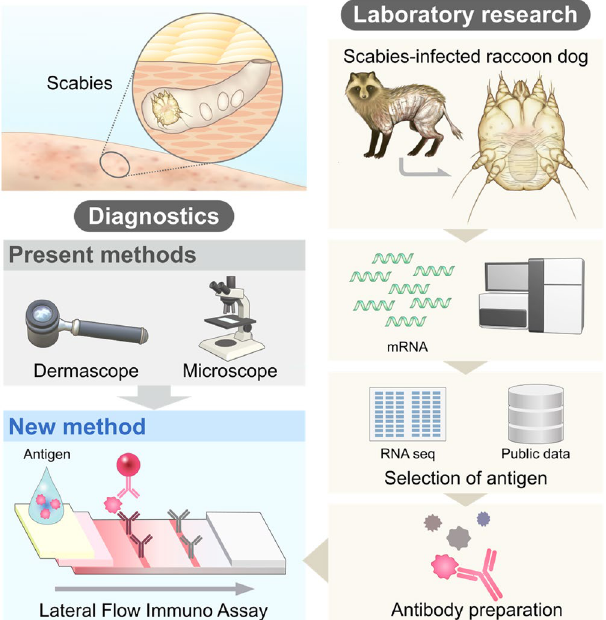
Figure 1. Schematic overview of this study for the development of a lateral immunoassay for scabies diagnosis. This is an original diagram drawn by co-author Chiaki Sakuma and